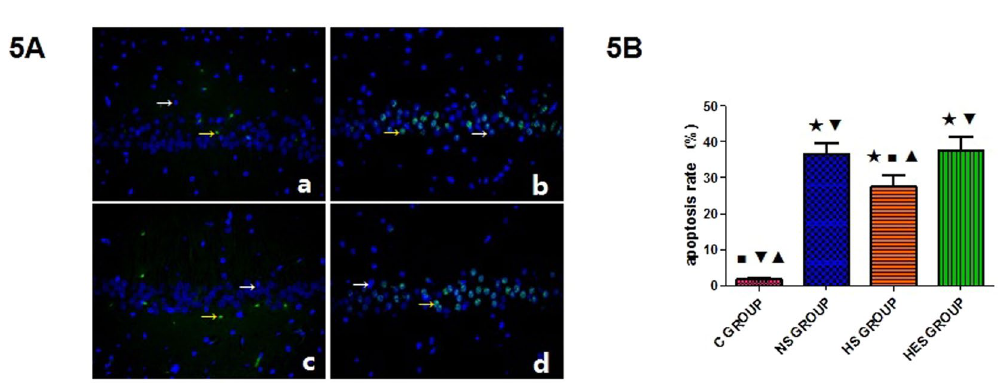
Figure 5. Hippocampal CA1 neuronal cell apoptotic rate by TUNEL. ( A ) Immunofluorescence staining for assessment of neuronal cell apoptosis in hippocampal CA1 at 72 hrs after ROSC in control (a), NS (b), HS (c) and HES (d) groups; Green stained cells are apoptotic cells and blue-stained region was cell nuclei; magnification, 400x. ( B ) Results of quantitative analysis for calculation of neuronal cell apoptosis rate. Yellow arrow points green fluorescence staining region which represented apoptotic cells and white arrow points blue fluorescence which represented cell nuclei. ★ P < 0.05 vs control group; ◾ P < 0.05 vs NS group; ▾ P < 0.05 vs HS group; ▴ P < 0.05 vs HES